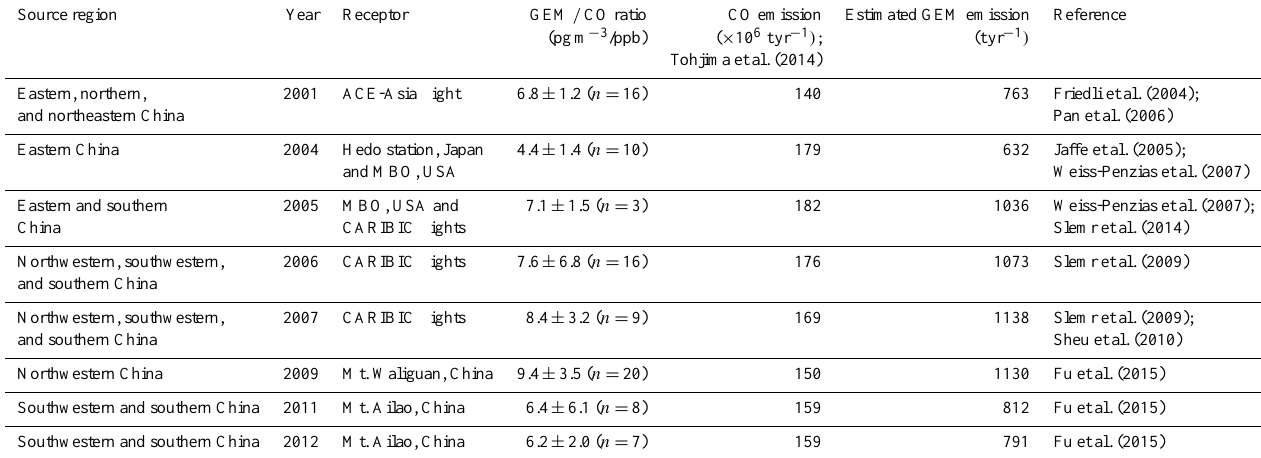
Table 2. GEM / CO ratios in air plumes and estimated GEM emissions in China. Source region Year